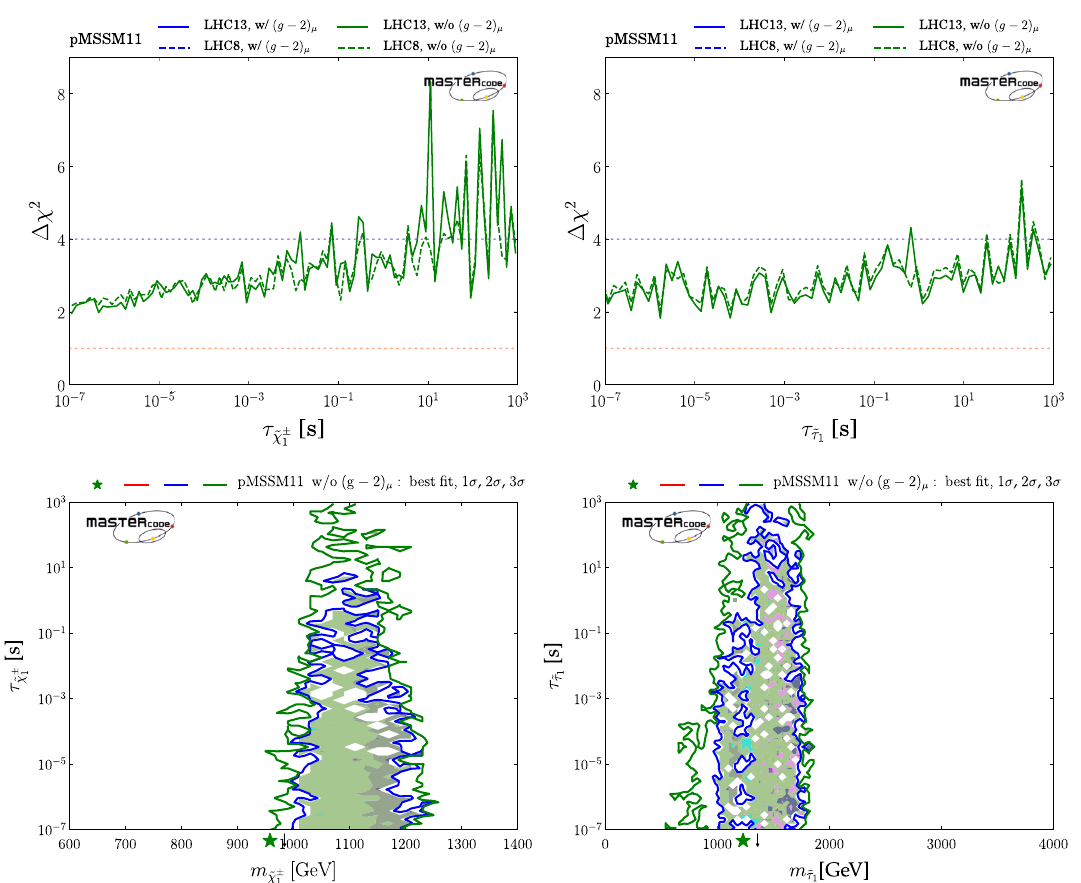
Fig. 19 Upper panels: One-dimensional profile likelihood plots for the lifetime of the ˜ χ ± mass-lifetime planes for the ˜ χ ± and ˜ τ 1 , with the 95% CL regions shaded according to the dominant DM 1